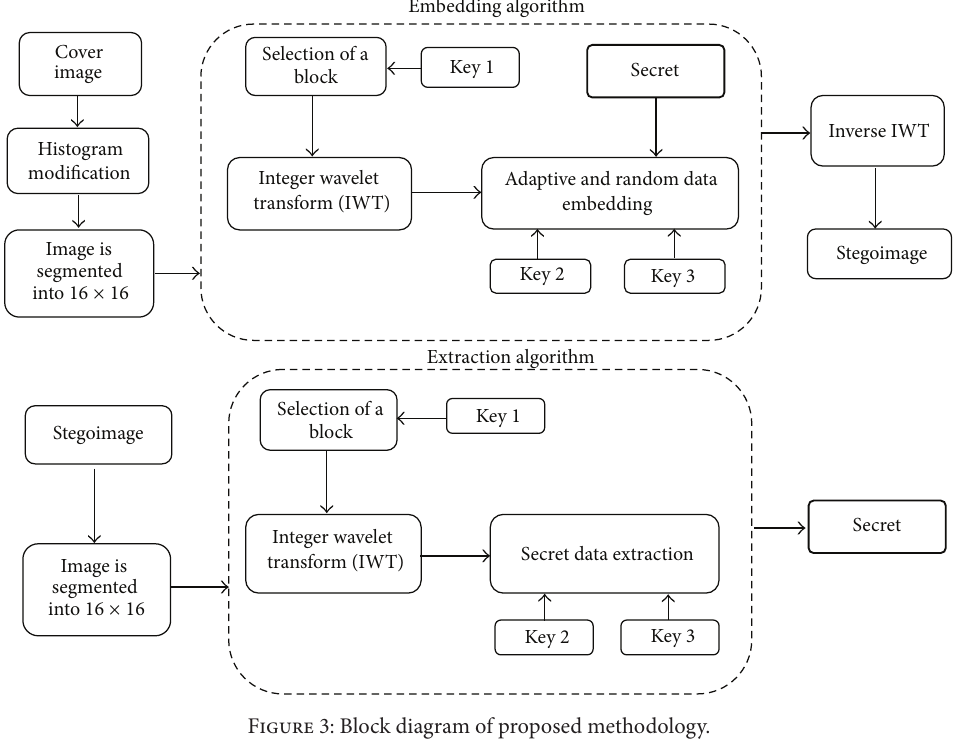
Figure 3: Block diagram of proposed methodology.